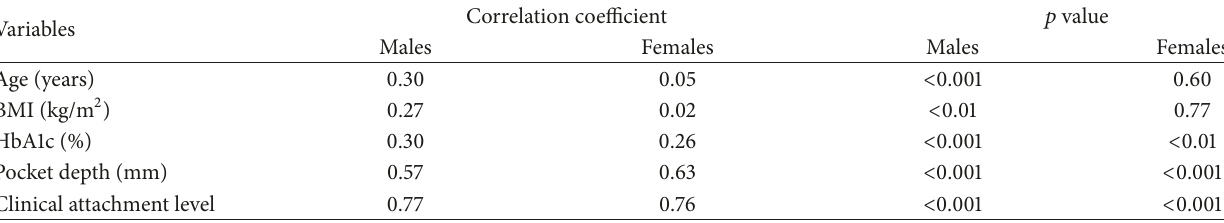
Table 5: Gender specific correlations of clinical variables with gingival index.